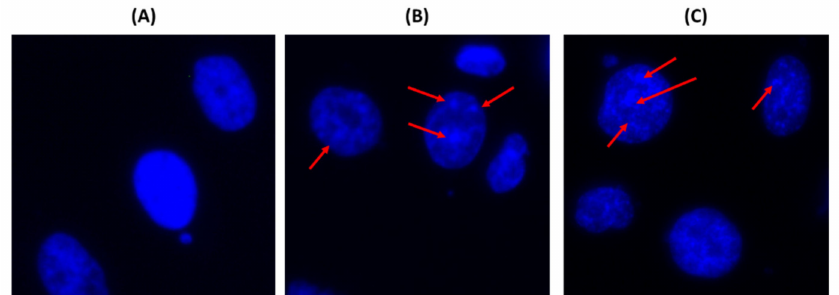
Figure 4. Chemical structure. After the NMR, HRMS, and FT-IR spectra were analyzed, the chemical structure and IUPAC name of the purified phytocompound were generated using ChemDoodle Software (iChemLabs, Ver. 9.0.3).